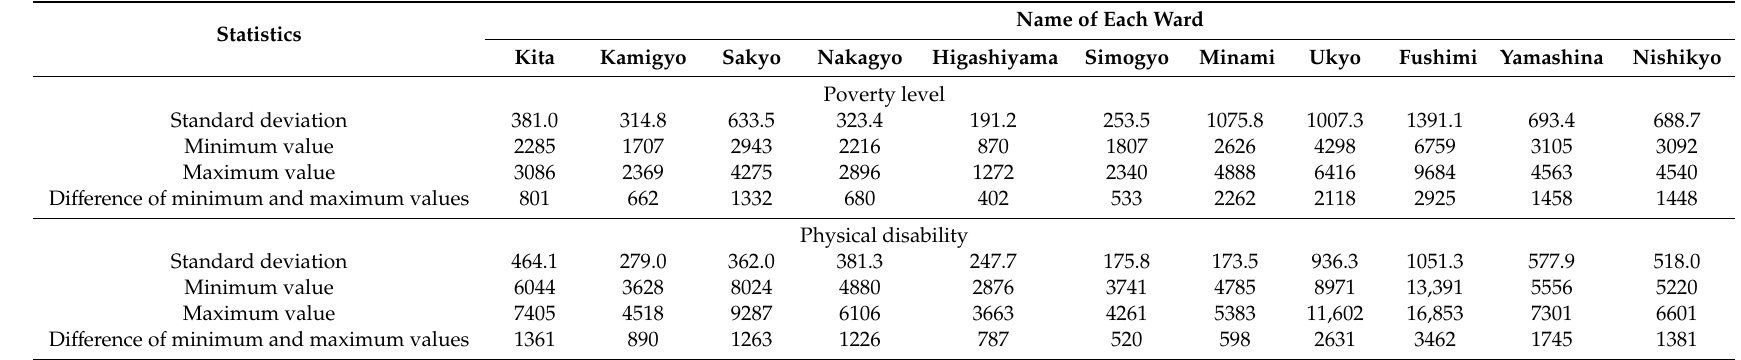
Table 4. The statistics of population number of poverty level and physical disability based on the historical data covering 7 years (2009–2015) and 15 years (2004–2018) in the 11 wards,